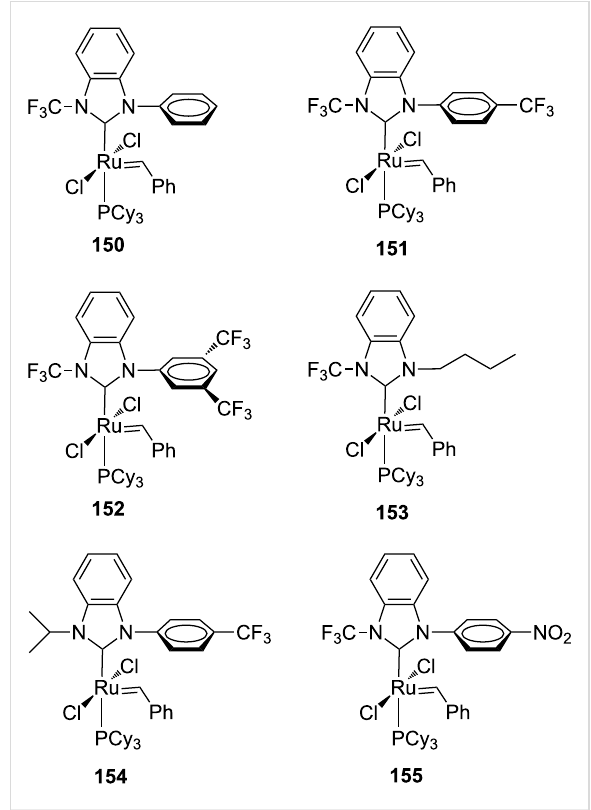
Figure 29: Grubbs-type complexes with N -trifluoromethyl benzimida- zolidene NHCs 150 – 153 , 155 and N -isopropyl benzimidazolidene NHC 154